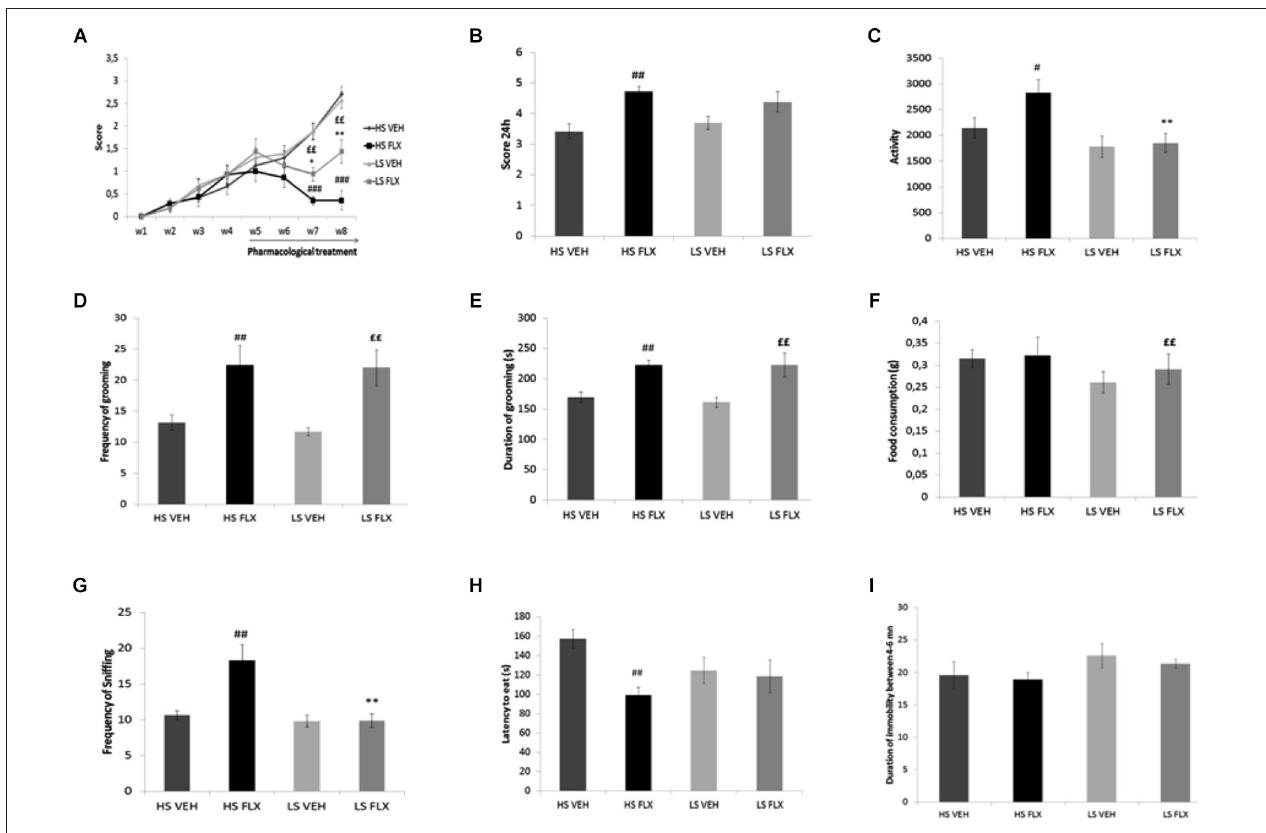
consumption in novelty suppression of feeding. (G) Frequency of sniffing in novelty suppression of feeding. (H) Latency to eat in the novelty suppression of feeding test. (I) Immobility in the tail suspension test. HS FLX vs. LS FLX: * p < 0.05, ** p < 0.01; HS